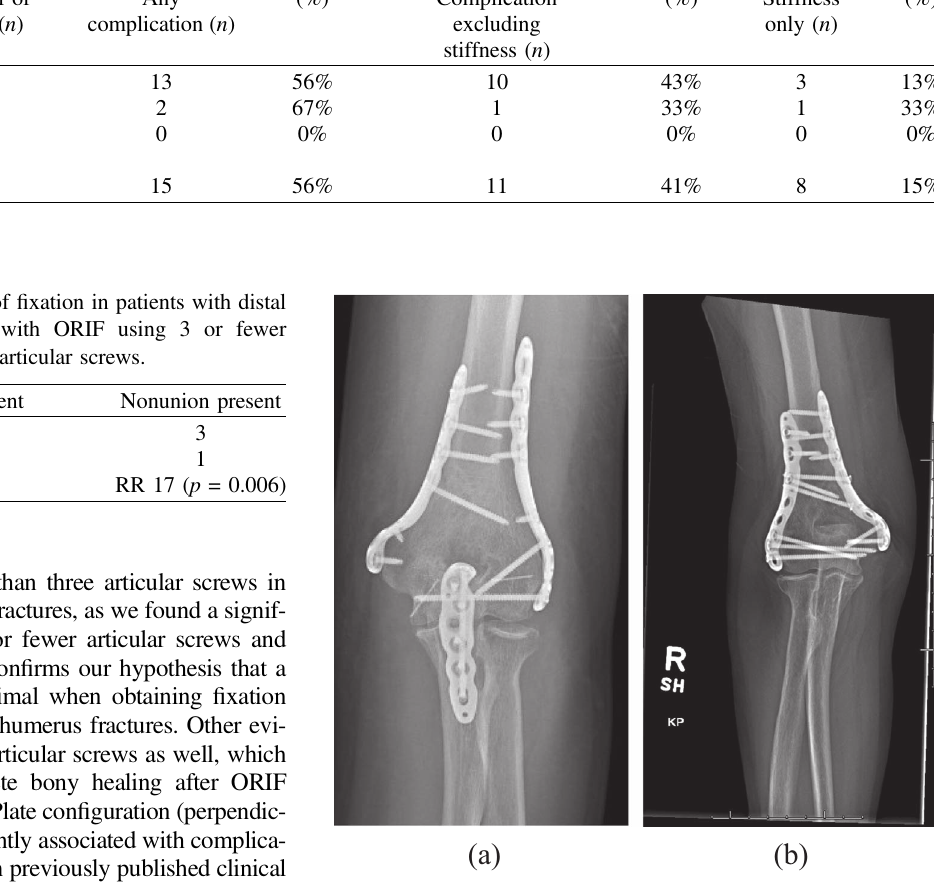
Figure 1. (a) AP radiograph 2 years post-op showing placement of 2 screws in distal fragment. Parallel plating of the distal humerus shaft is also shown in the image. There is osseous bridging across a trans fi xed olecranon osteotomy. (b) AP radiograph 2 years post-op showing articular reduction and complete bony healing of distal humerus fracture. The repaired construct included parallel plating with 5 articular fragment locking screws with interdigitation between the medial and lateral plate